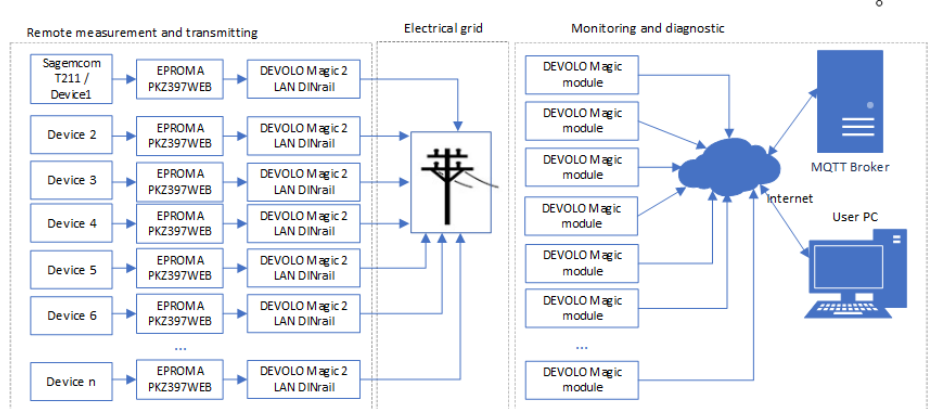
Figure 4. Block diagram of the deployed equipment and communication